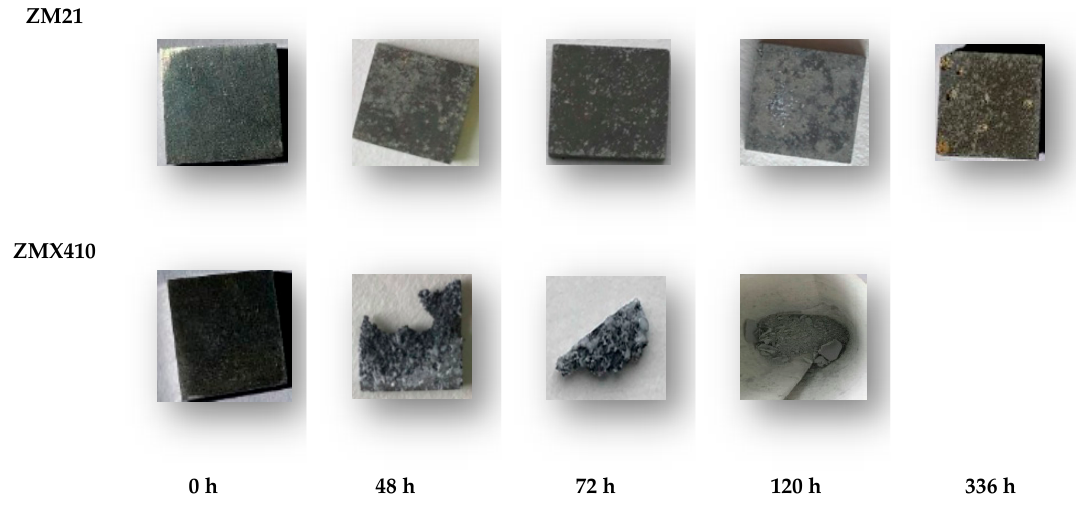
Figure 12. Aspects of the uncoated samples after immersion tests in SBF.